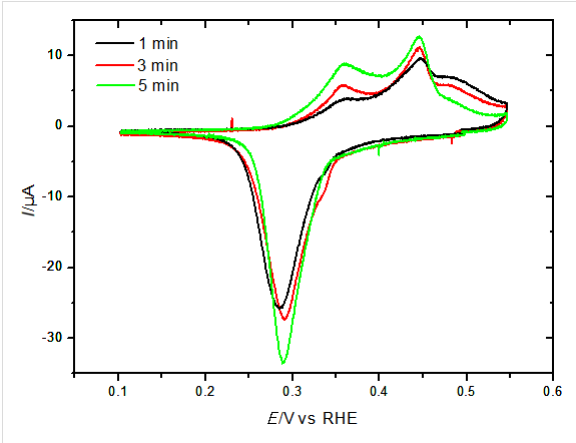
Figure 2: Cyclic voltammograms of Sb species on Au(111) in 0.1 M H 2 SO 4 electrolyte saturated with Ar at the sweep rate of 10 mV s − 1 . The irreversible adsorption of Sb species on Au(111) was induced after the electrode surface was in contact with Sb-containing elec- trolyte in the hanging meniscus configuration for 1, 3 and 5 min at open circuit potential ( ≈ 0.6 V). A nearly complete desorption of Sb from the Au(111) surface could only be achieved after extensive cycling in pure 0.1 M H 2 SO 4 . Then, the sulfate adsorption peaks and the correspond- ing spike at 1.05 V becomes discernible (see Supporting Information File 1, Figure S1). Obviously, some Sb remains incorporated in the Au surface and the Au(111) surface does not recover complete smooth-